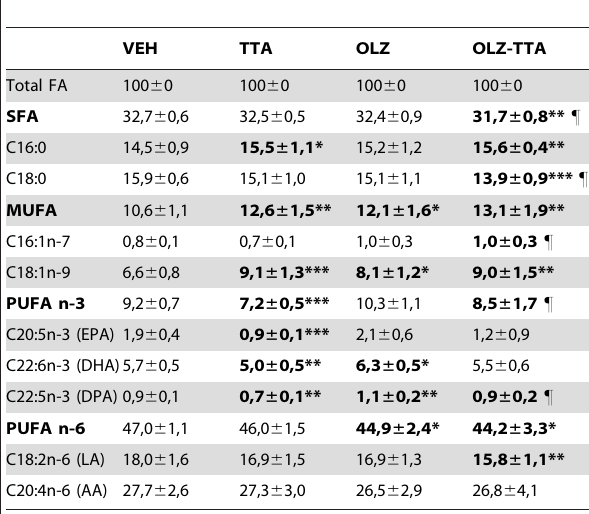
Table 2. Lipid subspecies in serum in the subchronic experiment.